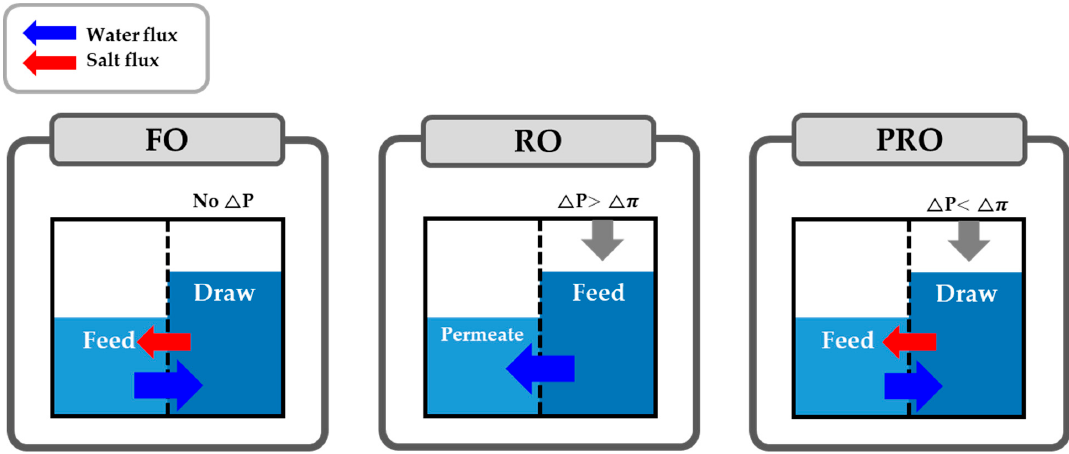
Figure 1. The schematic figures illustrating the mechanisms of forward osmosis (FO), reverse osmosis (RO), and pressure-retarded osmosis (PRO).